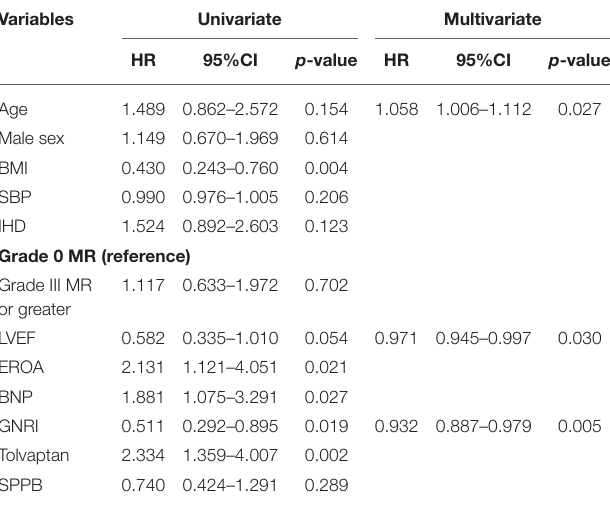
TABLE 2 | The univariate and multivariate Cox proportional hazard regression analyses to predict composite endpoint after discharge of patients with ADHF harboring FMR.